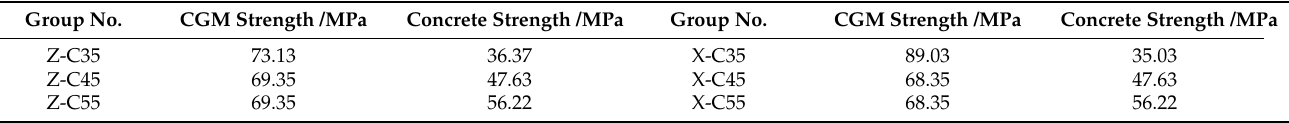
Table 4. Compressive strengths of the specimen